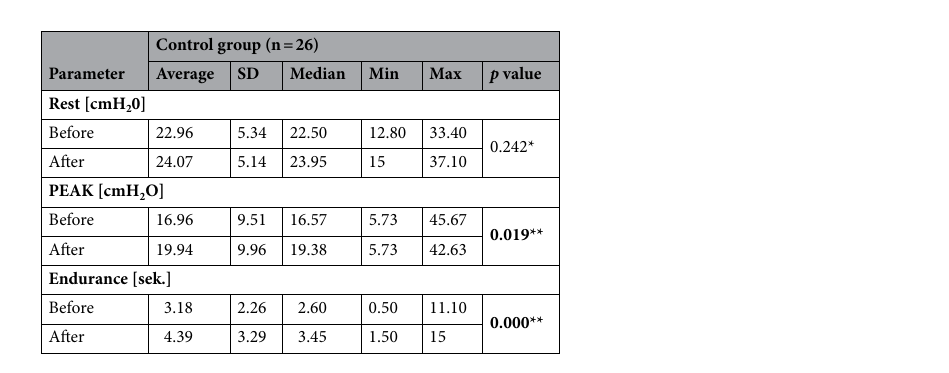
Table 3. Results of the resting pressure, peak pressure and endurance of the PFM using perineometer in the control group. Values statistically significant are in bold. *Anova with repeated measures with Fisher post-hoc test. **Wilcoxon test.